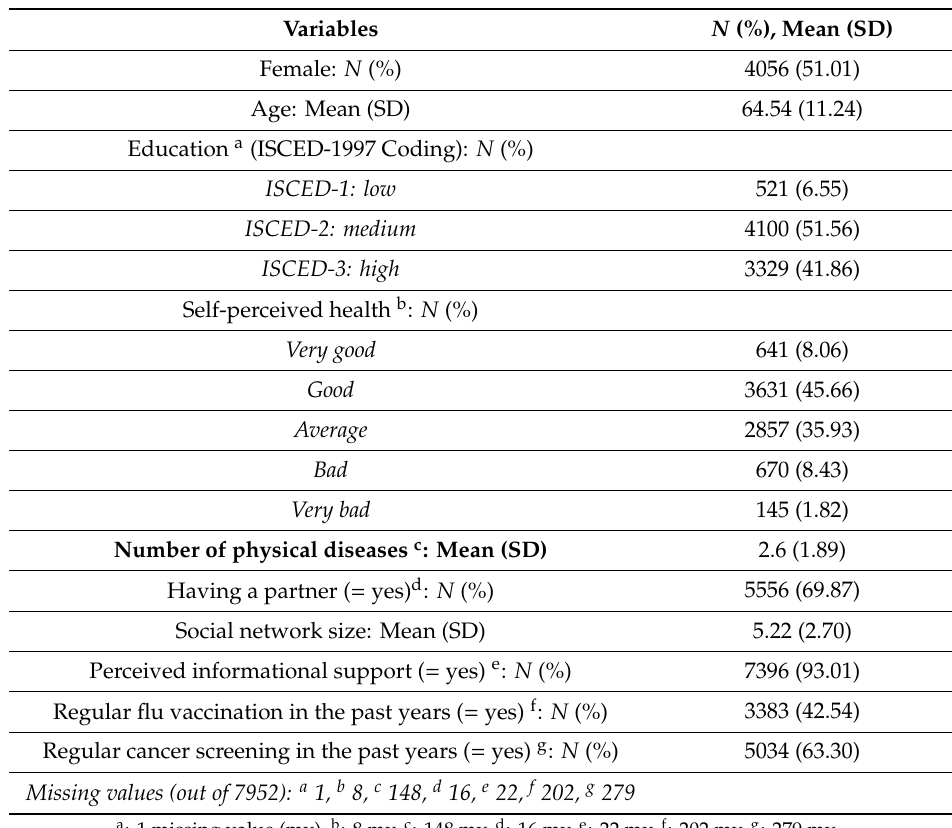
Table 1. Descriptive statistics of the sample by drop-o ff questionnaire ( n = 7952, (German Ageing Survey),